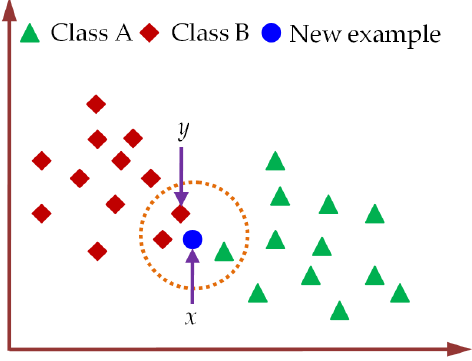
Figure 9. The assigning of class label to a new test sample using KNN classifier.